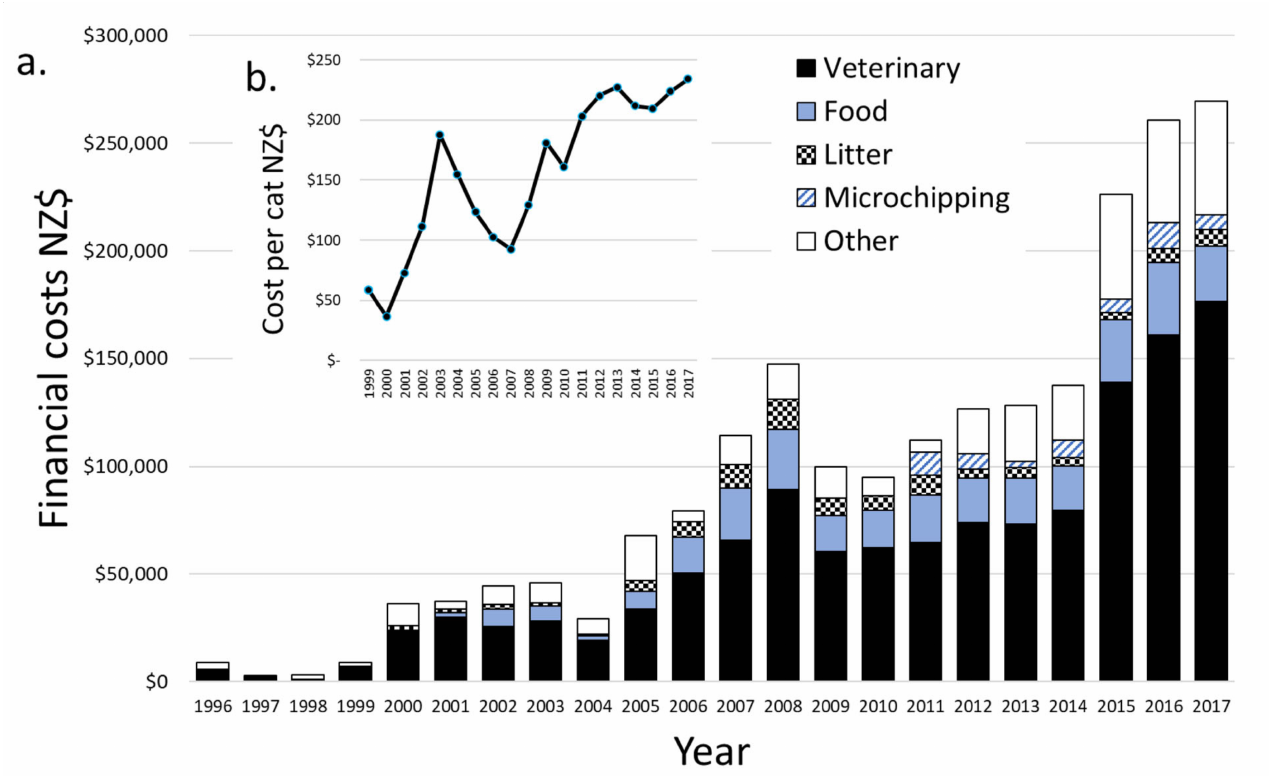
Figure 6. The financial costs of processing 13,062 stray cats (where reliable data were available) processed for trap–assess–resolve (TAR) through Lonely Miaow, Auckland, New Zealand, between 1996 and 2017, ( a ) by category of cost and ( b ) average estimated per